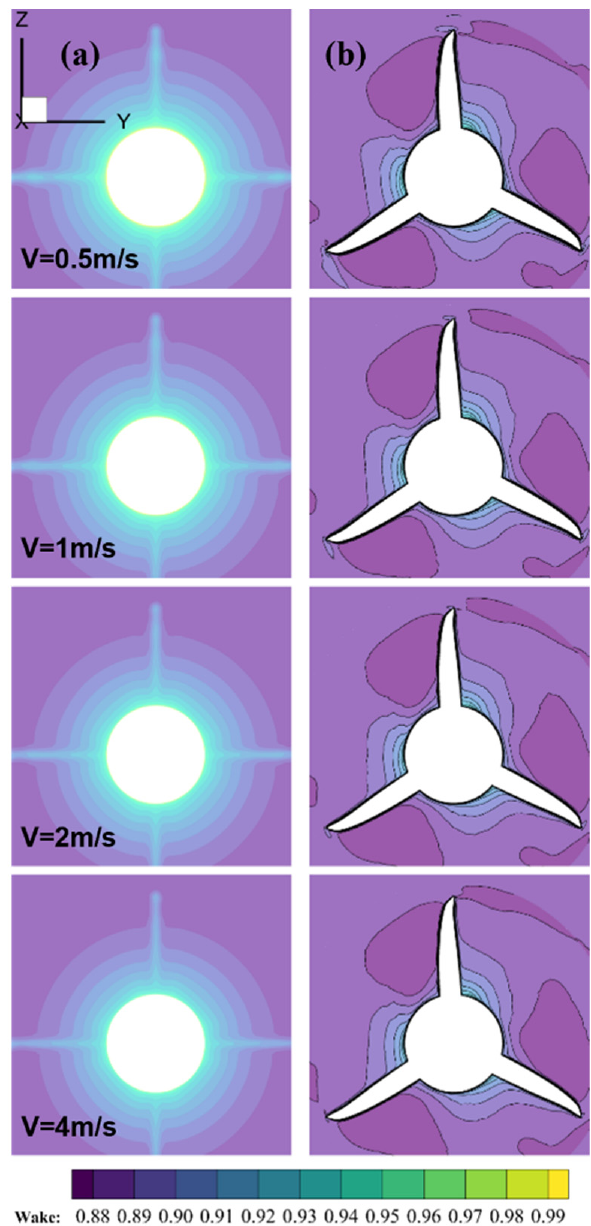
Figure 19. Cloud diagram of the wake fraction at the propeller disc for various Re L when Hd is 1.5. Columns ( a ) are for the bare UUV, and columns ( b ) are for the self-propelled UUV.